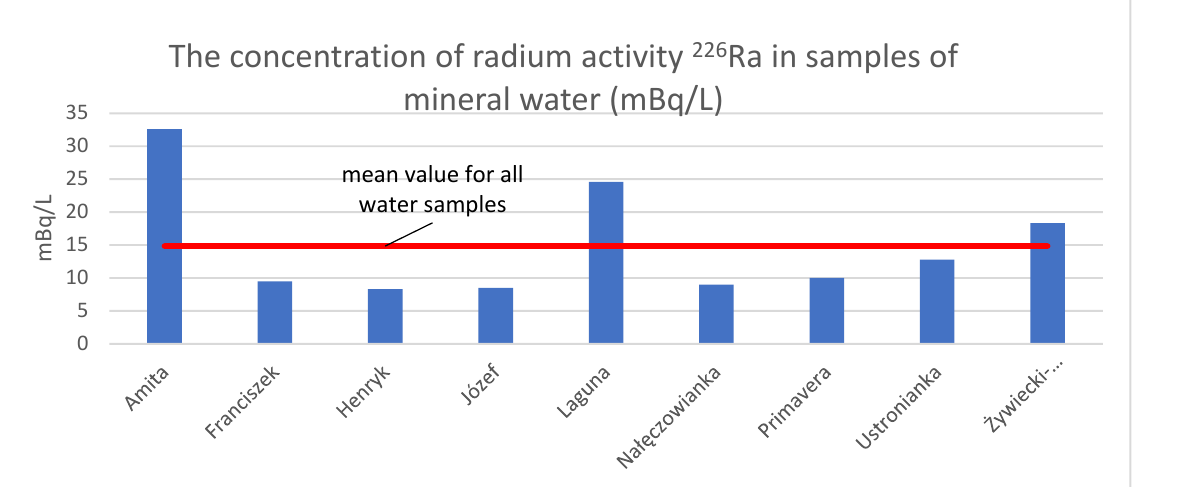
Figure 2. Concentrations of radium 226 Ra activity in 9 samples of mineral waters. The red line repre- sents the mean value for the set of samples.